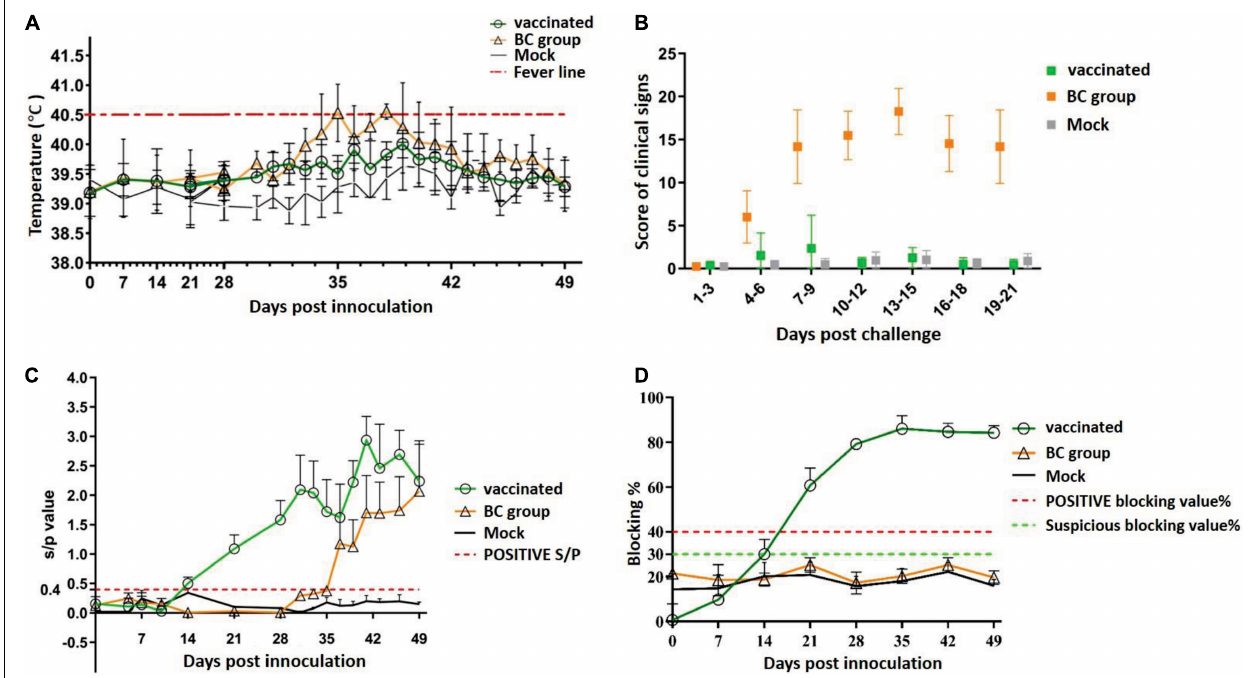
FIGURE 2 | Serological response after rPRRSV-E2 vaccination and scoring of clinical signs following challenge with the novel NADC30-like strain, ZJqz21. (A) Daily rectal temperature record and analysis following rPRRSV-E2 vaccination and ZJqz21 challenge. (B) Scoring and charting for clinical symptoms following rPRRSV-E2 vaccination and ZJqz21 challenge. Scoring data were indicated as the means ± standard deviations. (C) The S/P value assessed the PRRSV-specific humoral immune response (IDEXX PRRS X3) identified from serum samples collected at the indicated time points from piglets in the vaccinated, BC, and mock groups. (D) CSFV-specific antibodies in the three groups were tested in the serum samples collected in the experiments using an IDEXX CSFV Ab ELISA